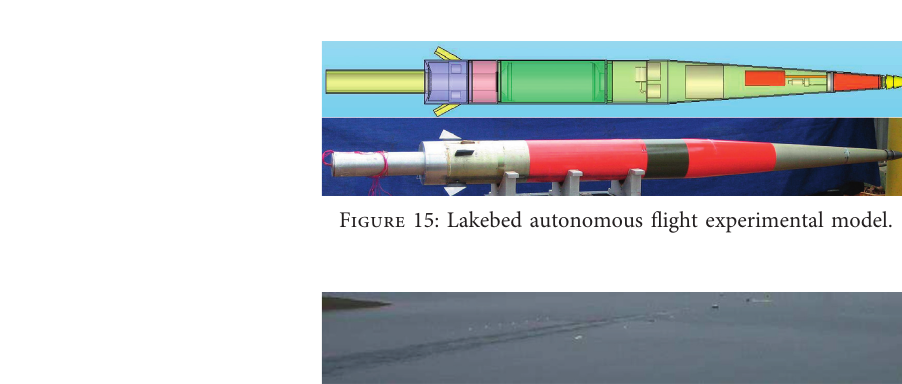
Figure 16: Surface trajectory.